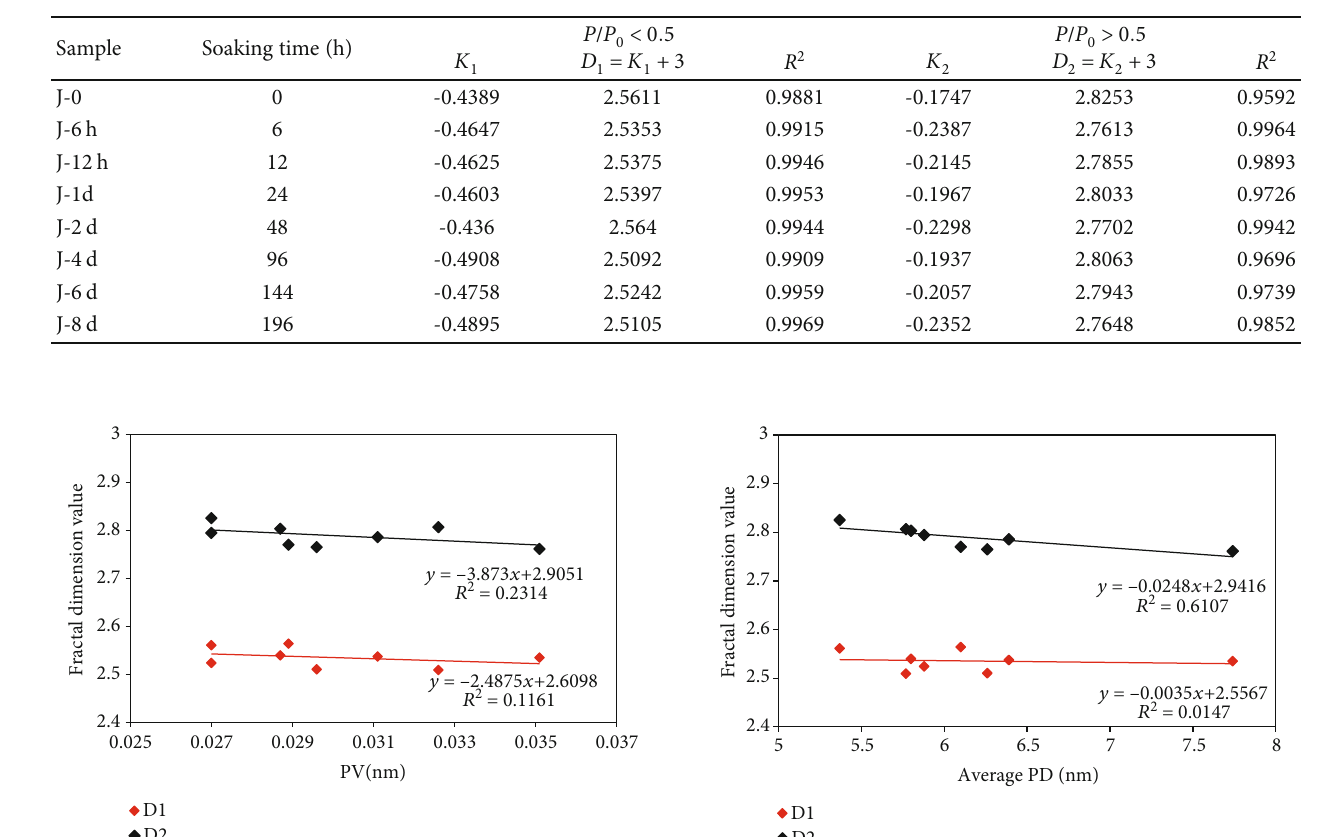
Table 2: Fractal dimensions of samples soaked in slick water for di ff erent times.